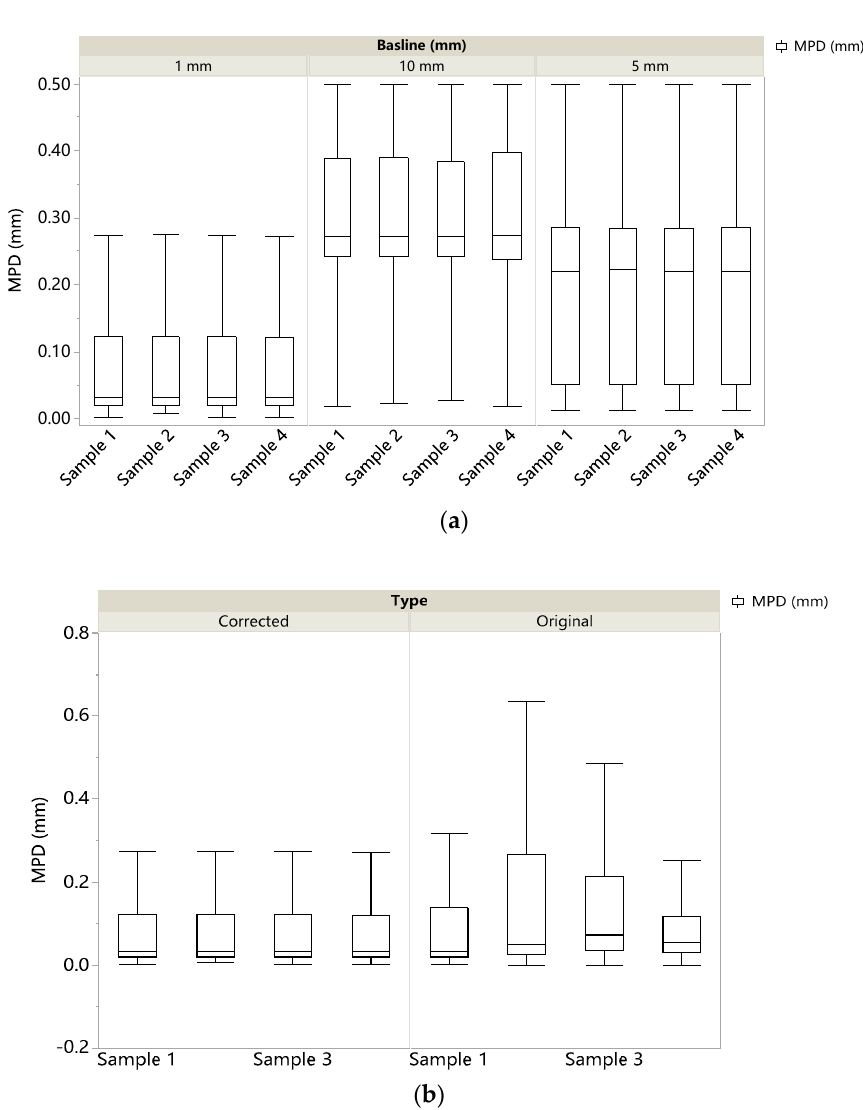
Figure 11. ( a ) the MPD distributions based on different baselines; ( b ) comparison of the MPD distributions between original and corrected profiles.